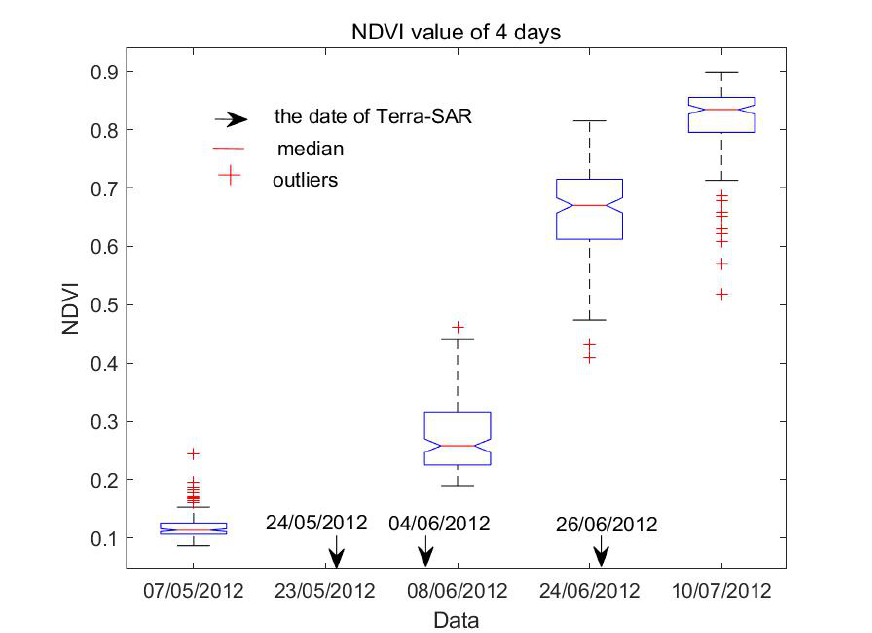
Figure 2. Boxplot of NDVI values obtained from four Landsat-7 images during the period from emergence stage to jointing